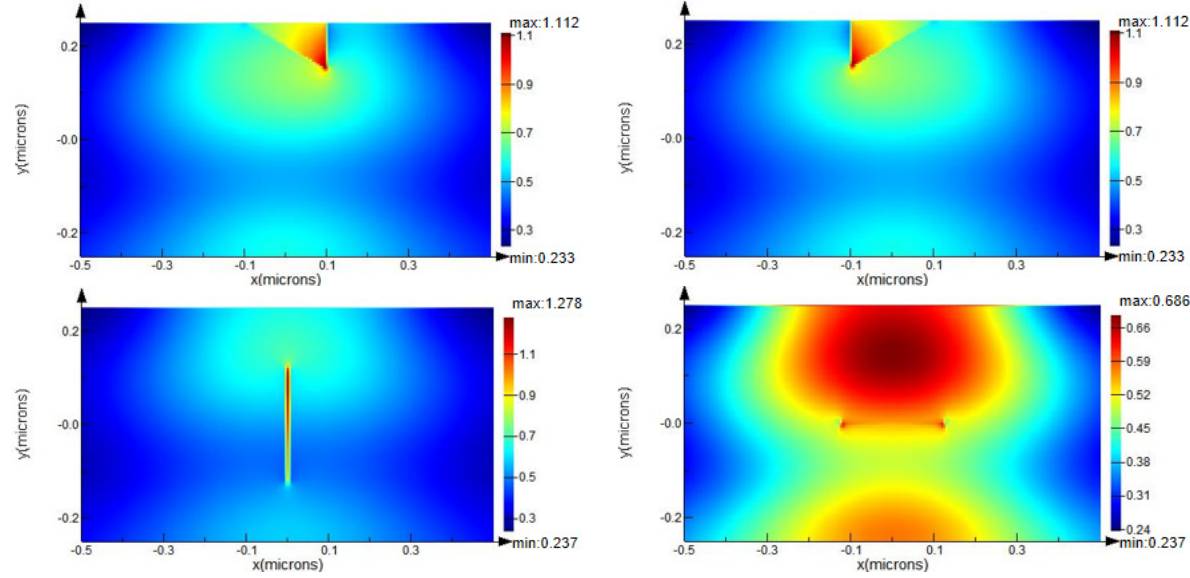
Figure 6. Light field distribution induced by crack defects (top) and scratch defects (bottom).